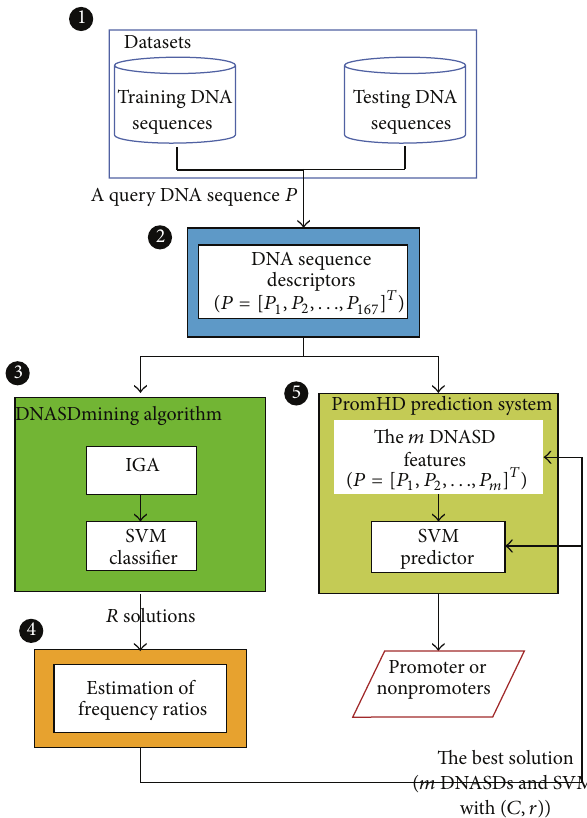
Figure 2: A block diagram of the PromHD method. The block diagram mainly contains the following important parts: (1) datasets, (2) DNA sequence descriptors, (3) DNASDmining algorithm, (4) estimating appearance-frequency ratios, and (5) PromHD predic- tion